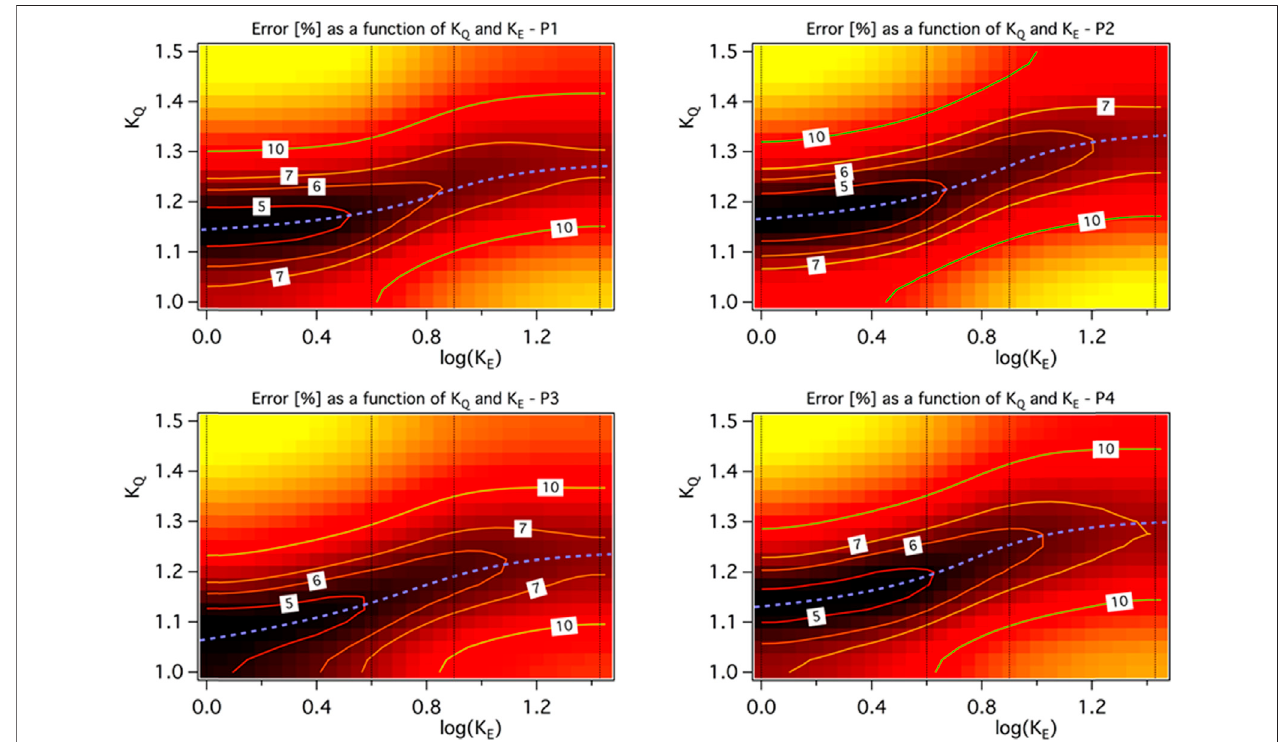
FIGURE12| DomainofcomputationaccuracyasafunctionofK E and K Q fortheexperiment casesP1-P4 (effectoflaserpower).Theminimumerrorispointed out with a blue dashed line.